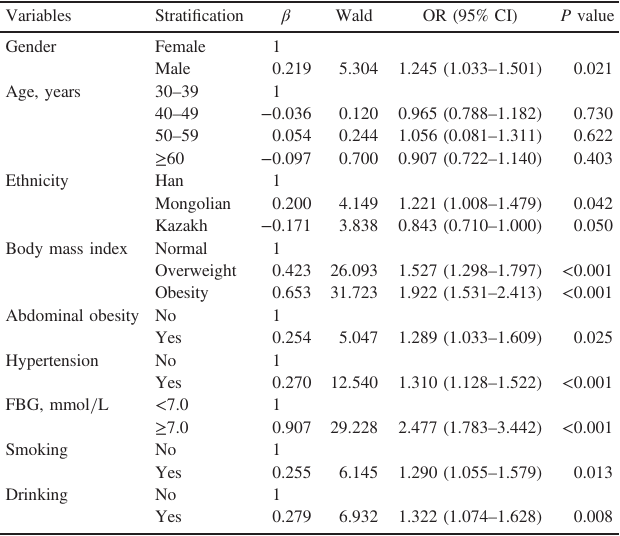
Table 4. Factors associated with the prevalence of dyslipidemia from multivariate logistic regression Variables